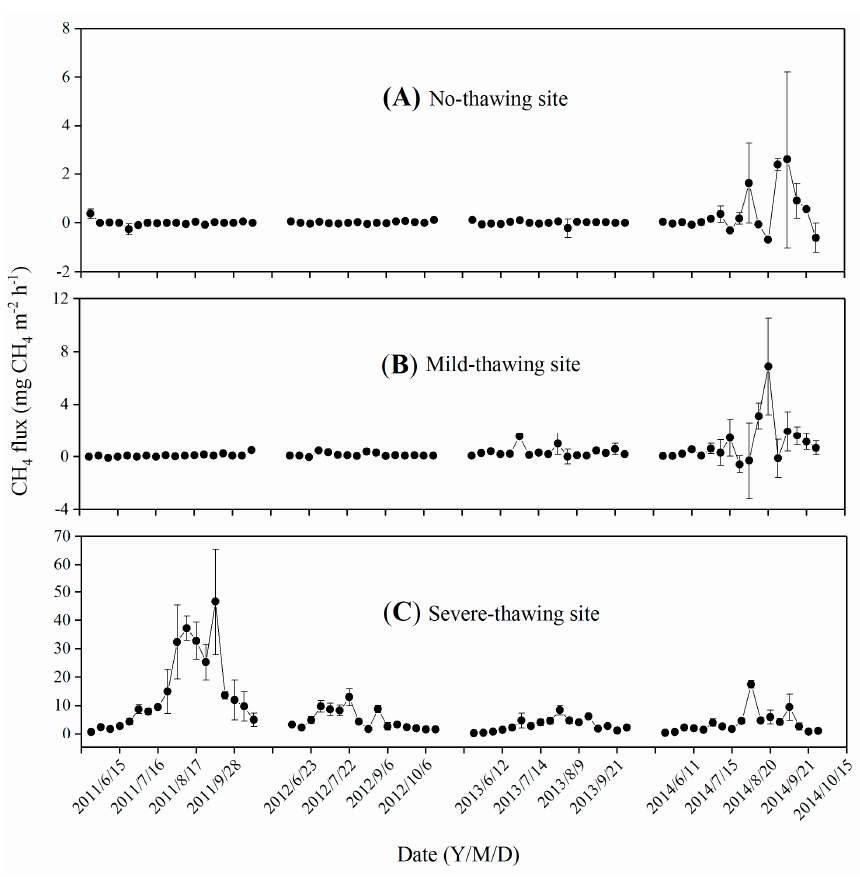
Figure 4. Seasonal variation of CH 4 fluxes in no-thawing ( A ), mild-thawing ( B ) and severe-thawing ( C ) sites. Data are means ± SE. n = 3 for the no-thawing site, n = 4 for the mild-thawing and severe-thawing sites.